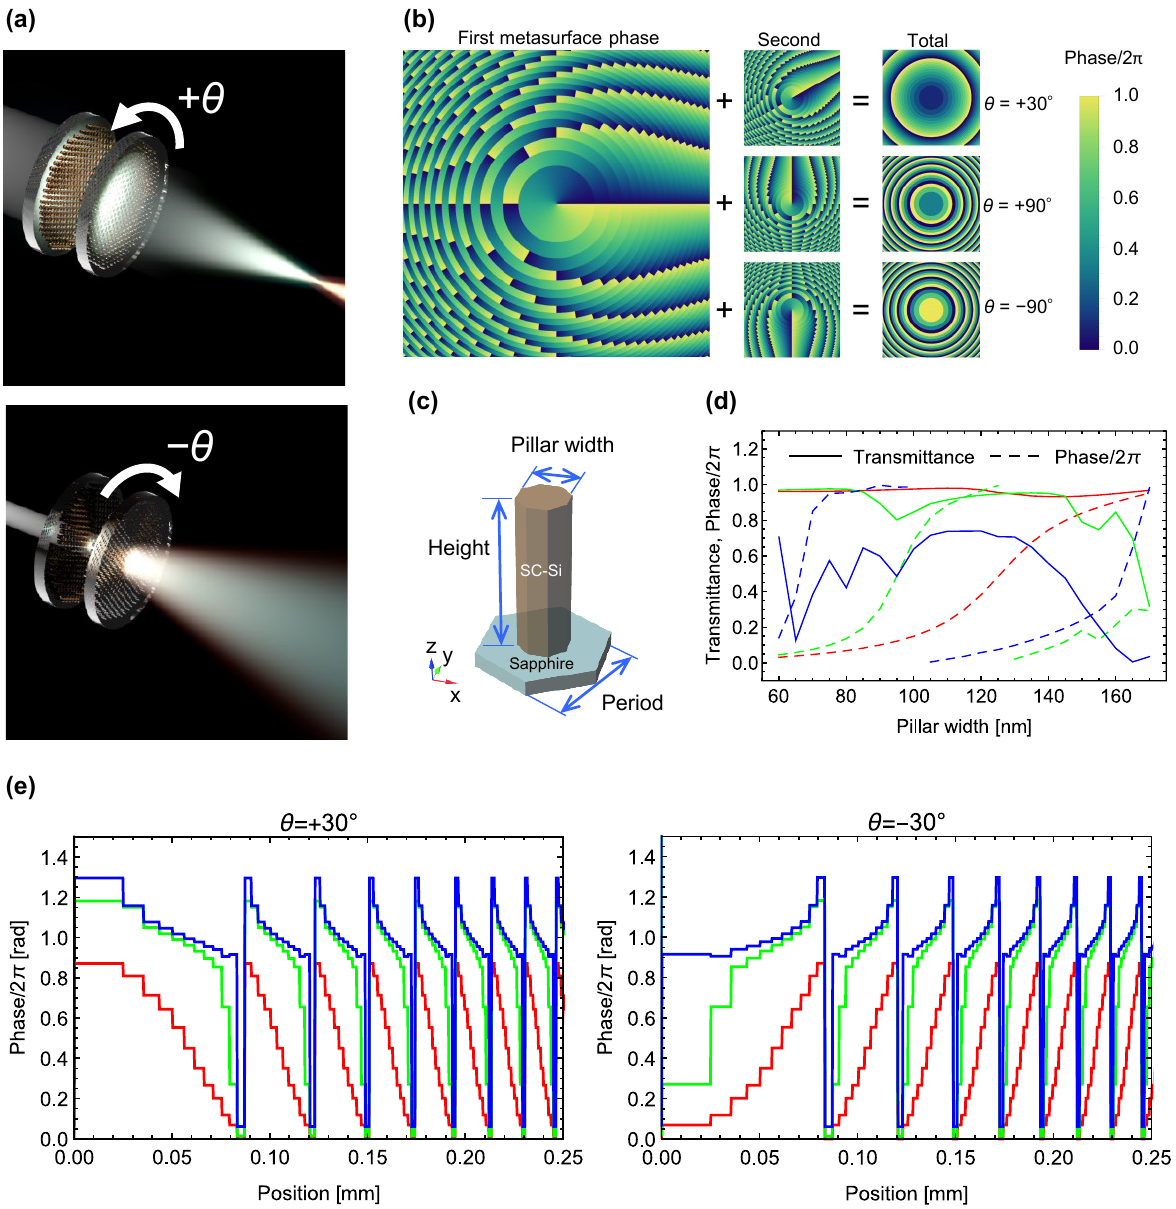
Figure 1: Design principle of a rotational varifocal (i.e., moiré) metalens. (a) Schematic drawing of focal length tuning. (b) Phase profiles of each metasurface and the overall metalens at different mutual rotation angles. (c) Schematic of an octagonal pillar meta-atom made of single-crystal in a hexagonal arrangement. (d) Simulated transmission property as a function of the pillar width. Solid and dashed lines indicate the transmittance and phase/2 𝜋 , respectively. The plot colors of red, green, and blue correspond to the wavelengths of 633, 532, and 442 nm, respectively. (e) Phase profiles around the center of the designed moiré metalens with the diameter of 2 mm at mutual rotation angles of + 30 ◦ (left) and − 30 ◦ (right) and wavelengths of 633 (red), 532 (green), and 440 (blue)